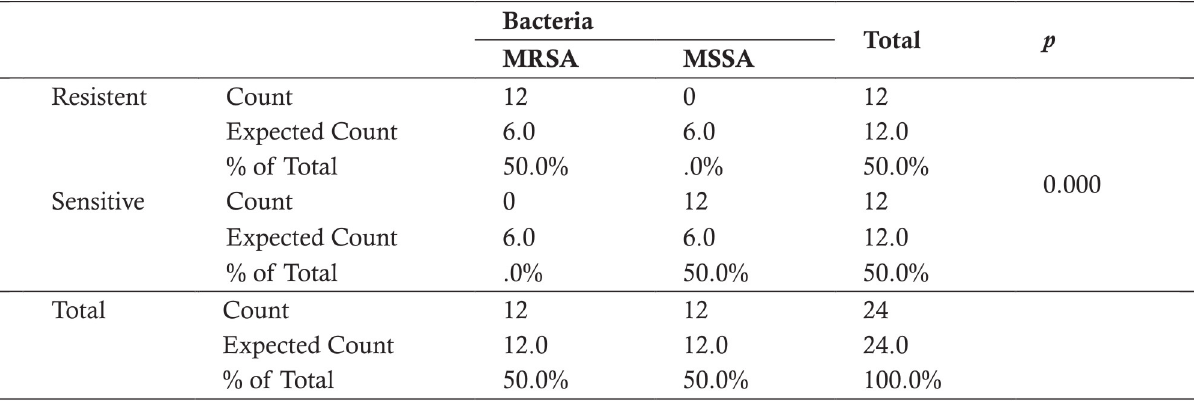
Table . Cross tabulation of cefoxitin disk